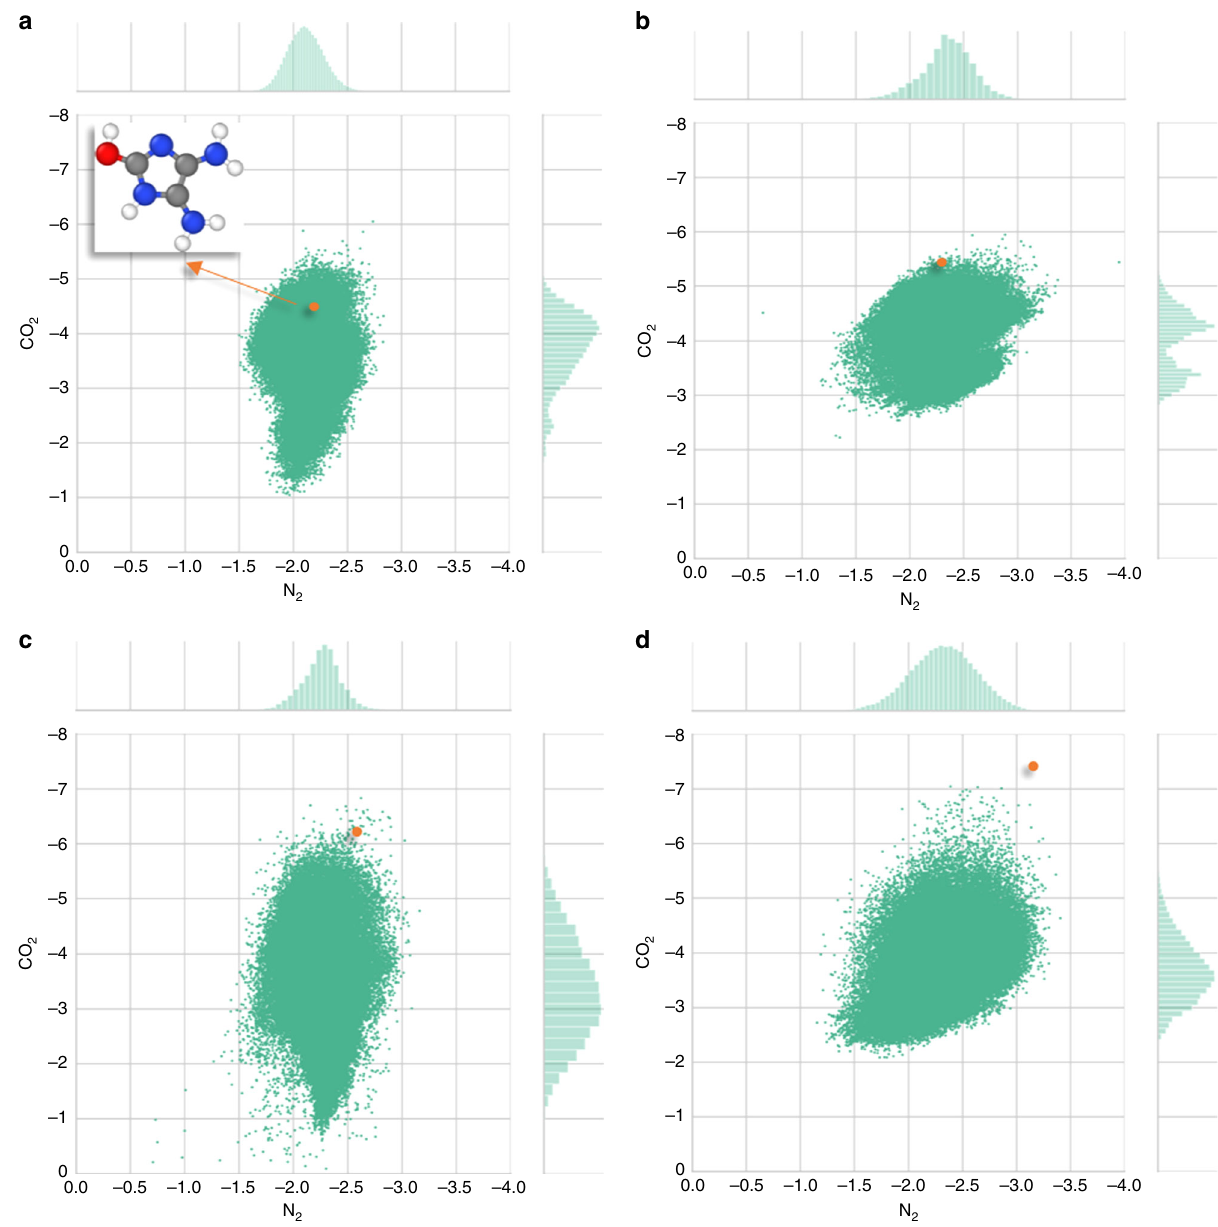
Fig. 6 Predicted CO 2 and N 2 interaction energies (in kcal mol − 1 ) for all molecules in the GDB-9 database using four molecular representation models. ( a ) CM, ( b ) BoB, ( c ) SOAP, and ( d ) PI. Only the model that utilized the PI molecular representation was able to identify 4,5-diamino-1H-imidazol-2-ol (inset) as the strongest CO 2 -philic groups (shown with an orange dot on each